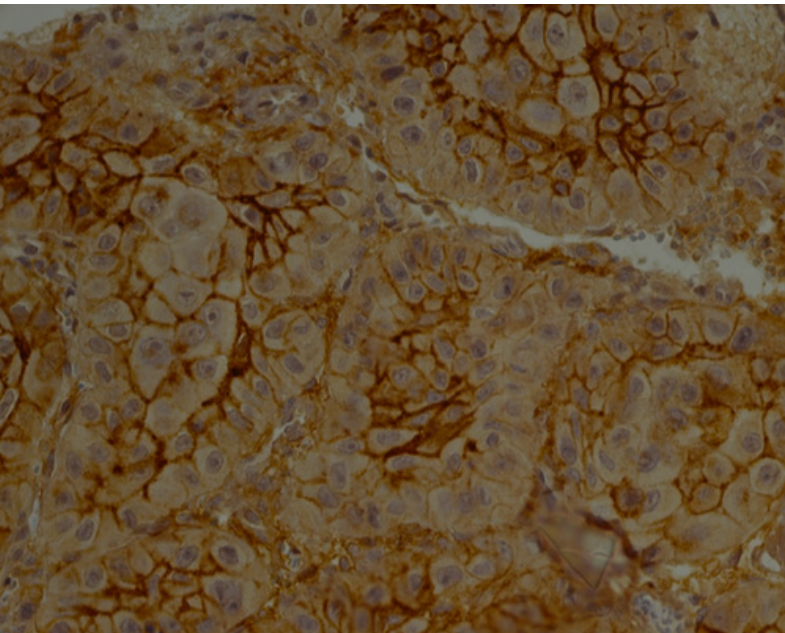
Figure 6. TNF- α —strong brown staining in epithelial cells of OSCC (40x).